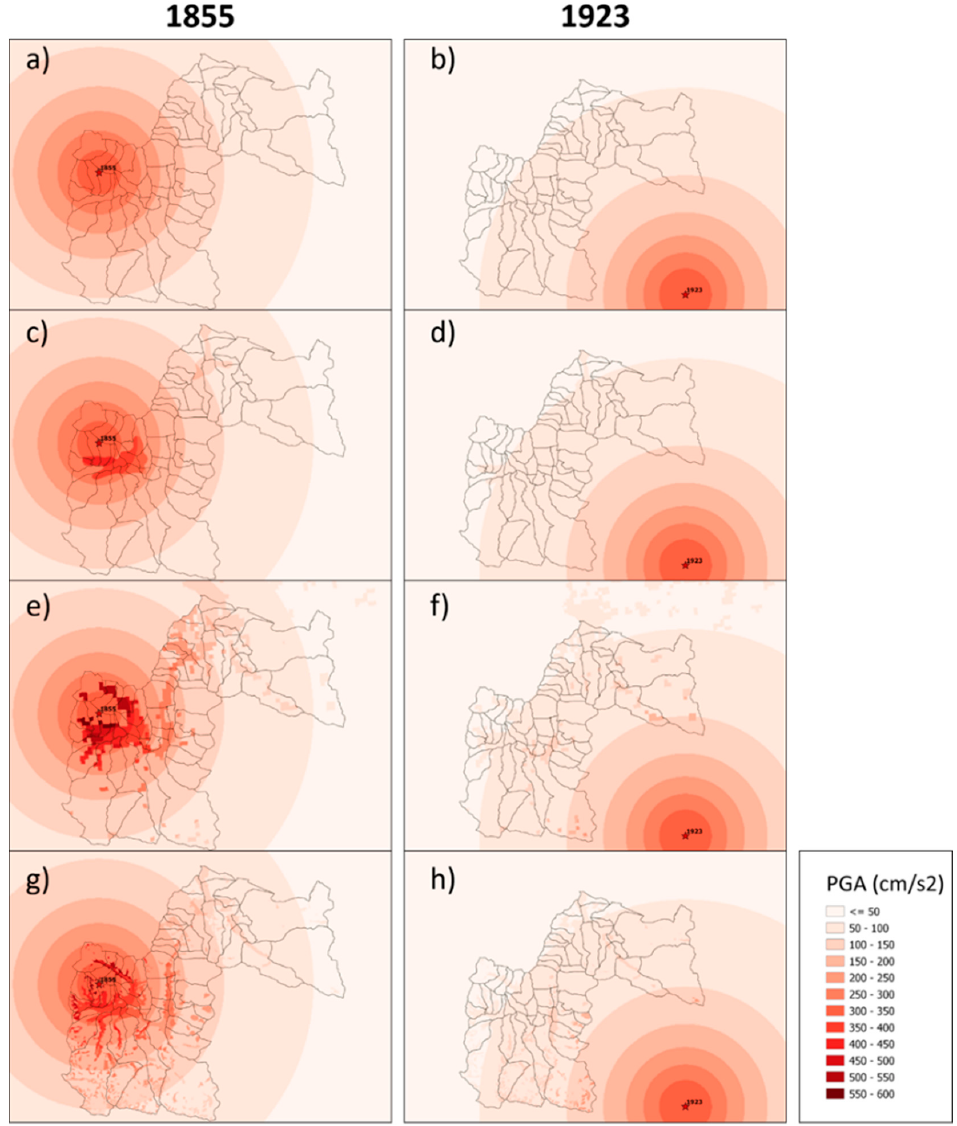
Figure 8. The ground motion corresponding to the earthquakes of 1855 ( left ) and 1923 ( right ): The first row ( a and b ) shows the ground motion computed at rock site conditions following the GMPE from [72]. The surface ground motion is amplified due to the soil effect using SS1 ( c and d ), SS2 ( e and f ) and SS3 ( g and h ) soil characterization maps.